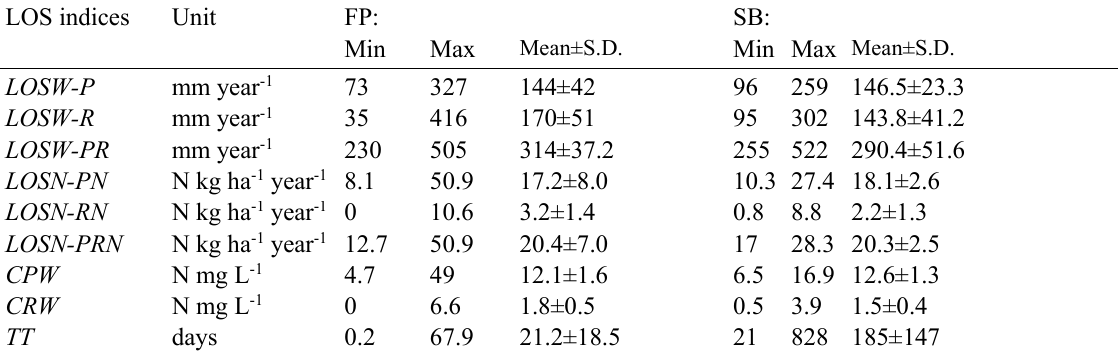
Table 1 Minimum, maximum and mean pixel values for each LOS index. LOS